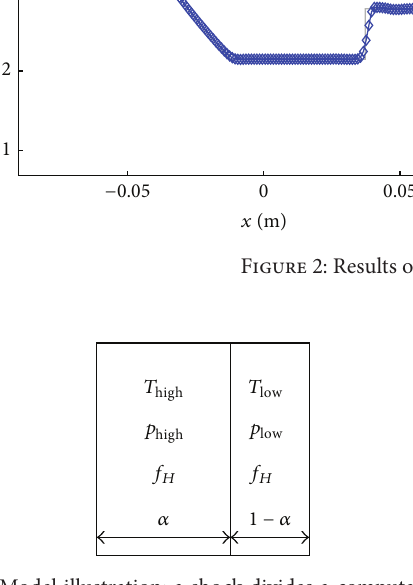
Figure 3: Model illustration: a shock divides a computational cell into a volume fraction 𝛼 of high temperature and pressure and a volume fraction 1 − 𝛼 of low temperature and